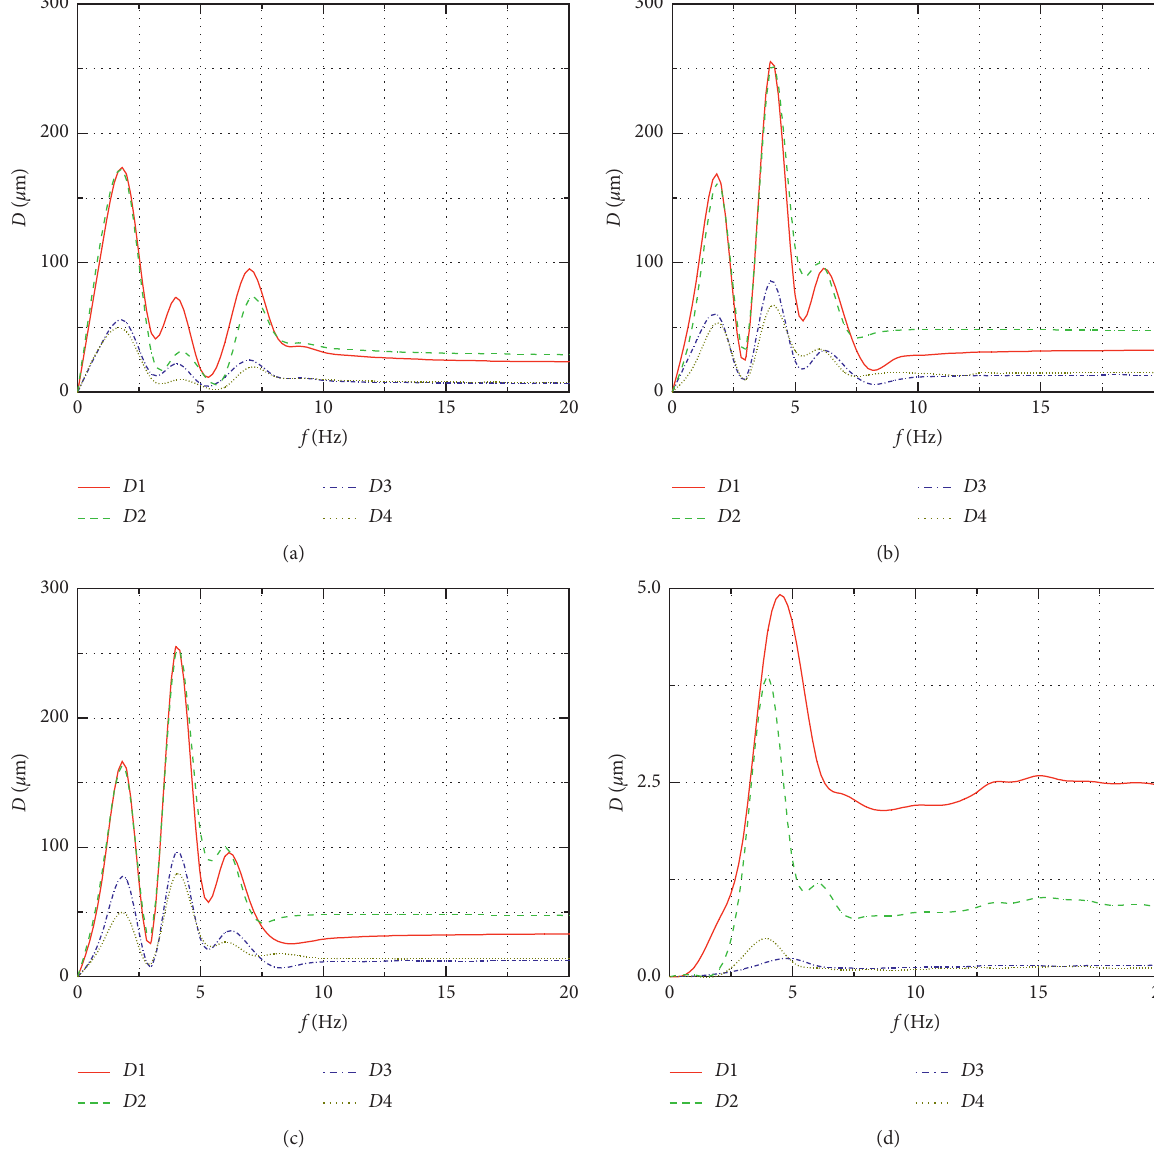
Figure 5: Typical displacement–frequency curves: (a) PT1X, (b) PT1Z, (c) SB1Z, and (d) FS1Z.